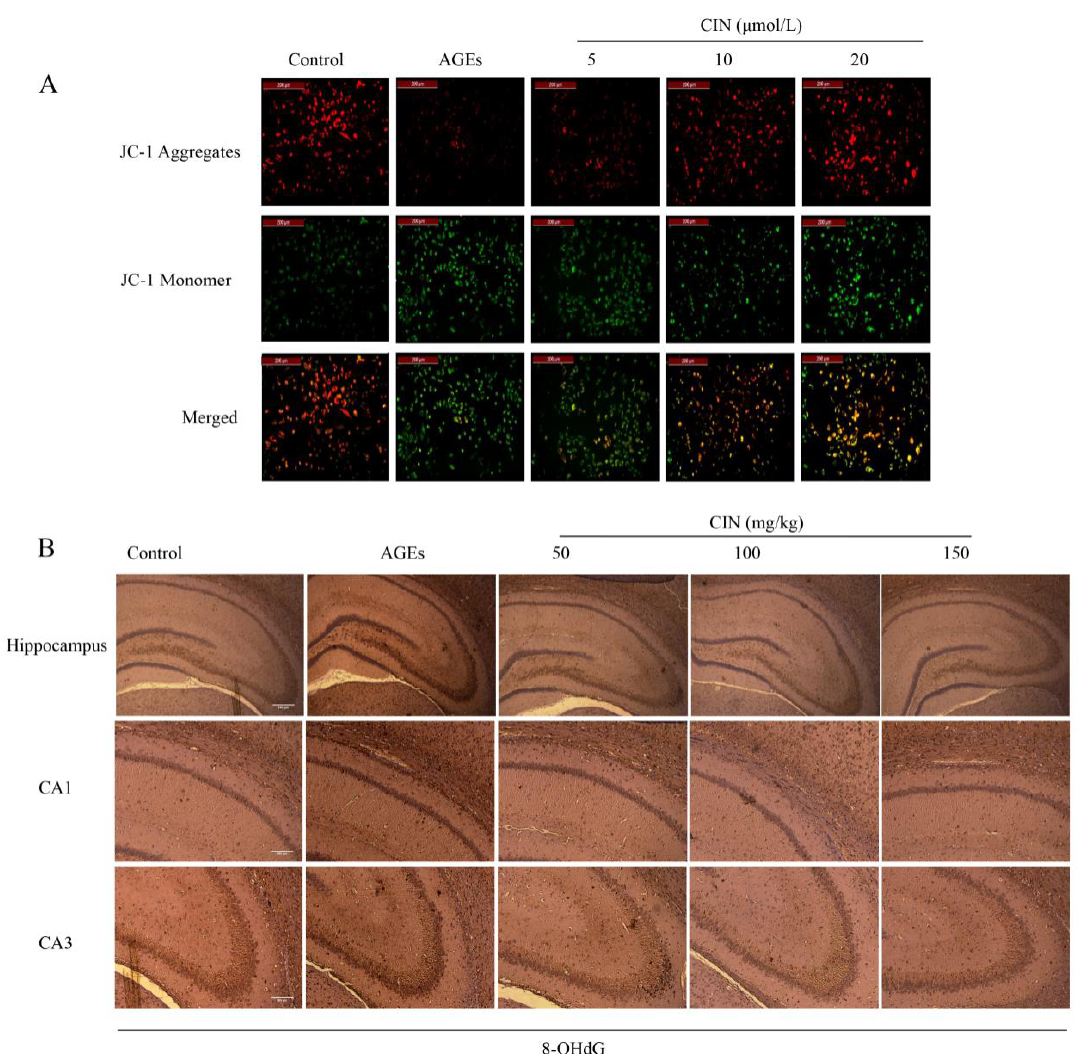
Figure 2. Effects of CIN on AGEs-induced oxidative damage. ( A ) Mitochondrial membrane potential was detected by JC-1 staining and viewed by fluorescence microscope (scale bar = 200 µ m). ( B ) IHC staining of rat brain immunostained with antibody against 8-OHdG (scale bar, hippocampus group: 500 µm; CA1, CA3 group: 250 µm).